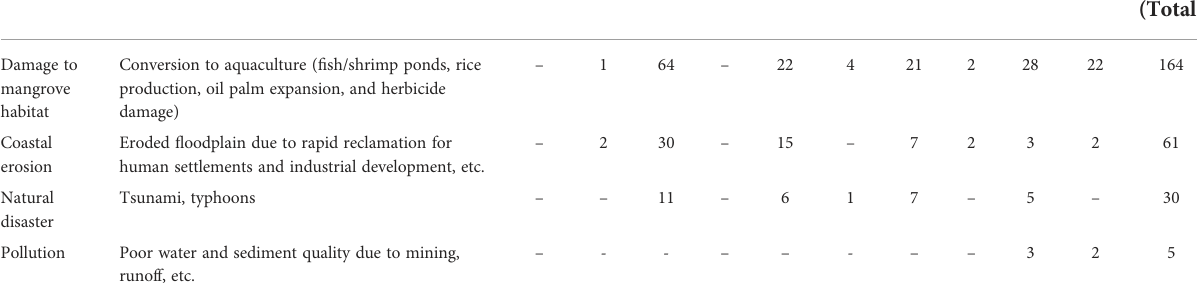
TABLE 3 Summary of general problems addressed by mangrove restoration from each country and in Southeast Asia. General